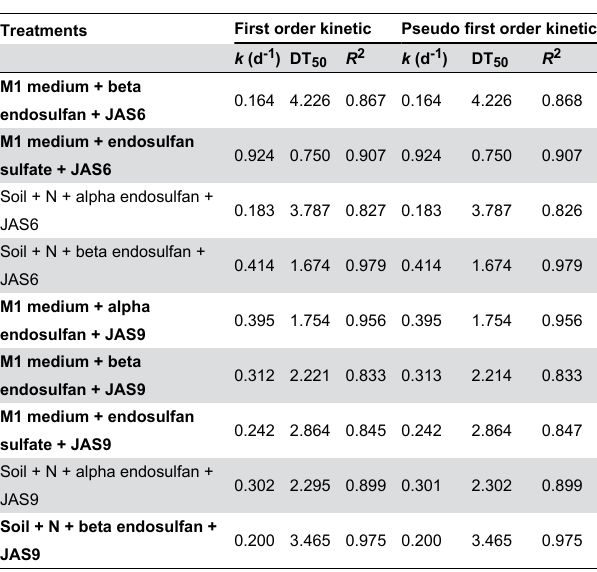
Table 2. Kinetic parameters for the degradation of endosulfan and its metabolites by Botryosphaeria laricina JAS6 and Aspergillus tamarii